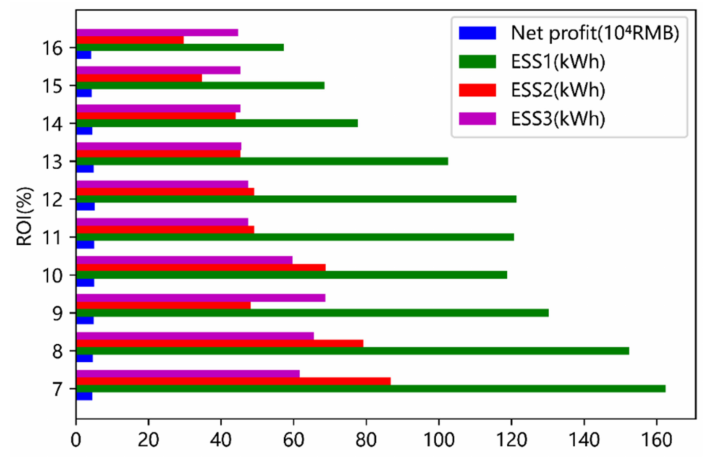
Figure 11. The optimal capacities and net profit of ESS under different